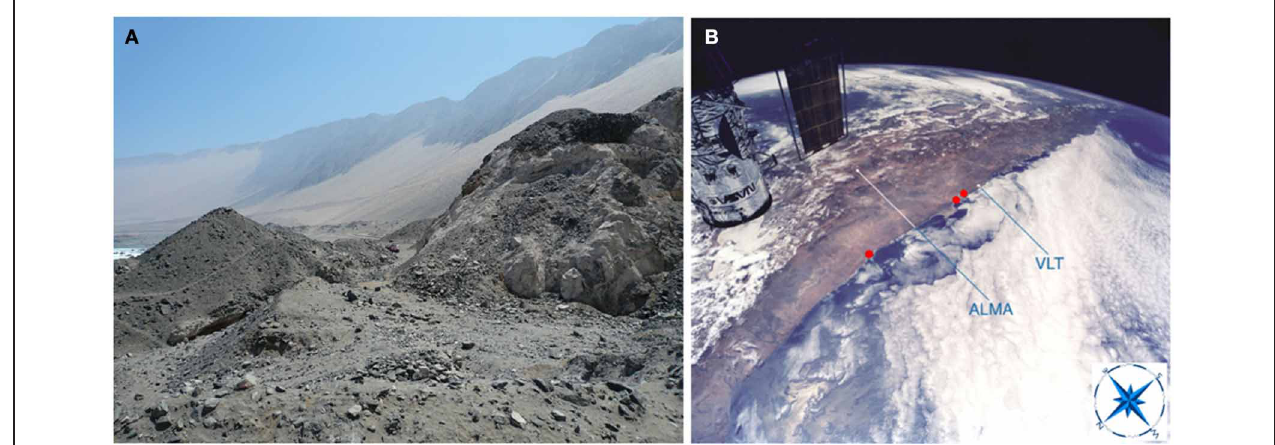
FIGURE 1 | The Atacama Desert Coastal Range. (A) The Coastal Range runs along the western margin of the Atacama Desert, with its hills falling abruptly on the Pacific Ocean. At the center left, part of the Pacific Ocean can be seen. For scale, a pickup truck can be barely seen at the center of the image. (B) View of the Coastal Range sites detailed in this work, as seen from the NASA Space Shuttle during a servicing mission to the